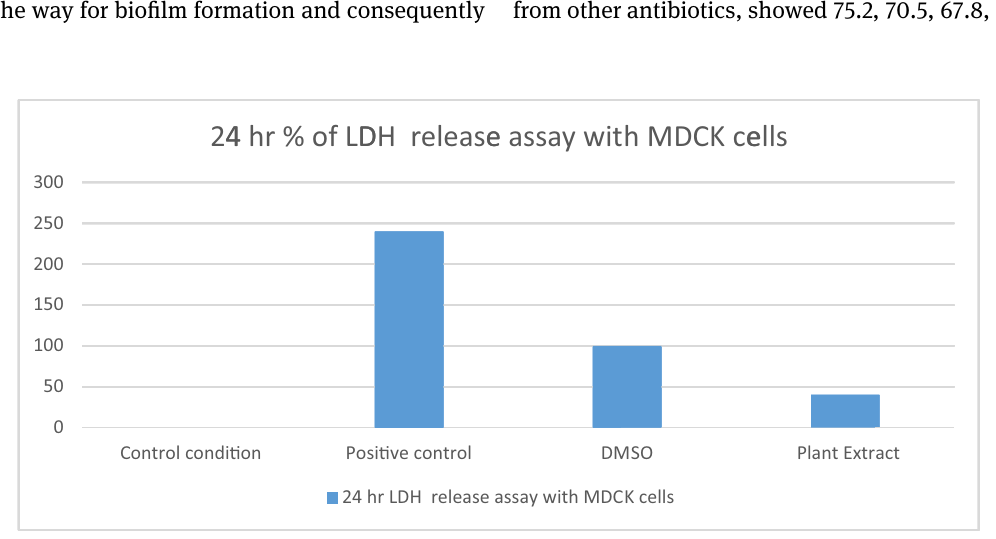
Figure 6: The percentage of LDH release with plant extract, control, DMSO, and positive control after 24 h incubation with MDCK cells.